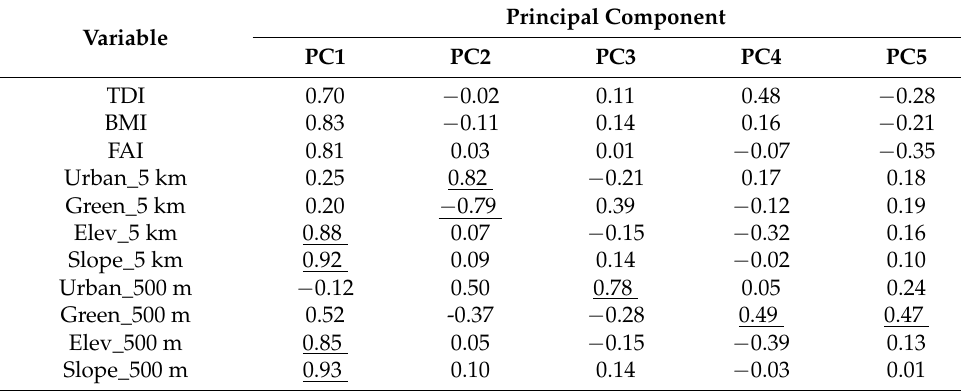
Table 5. Rotated factor matrix extracted from principal component analysis. The underline values are the largest weighs on that